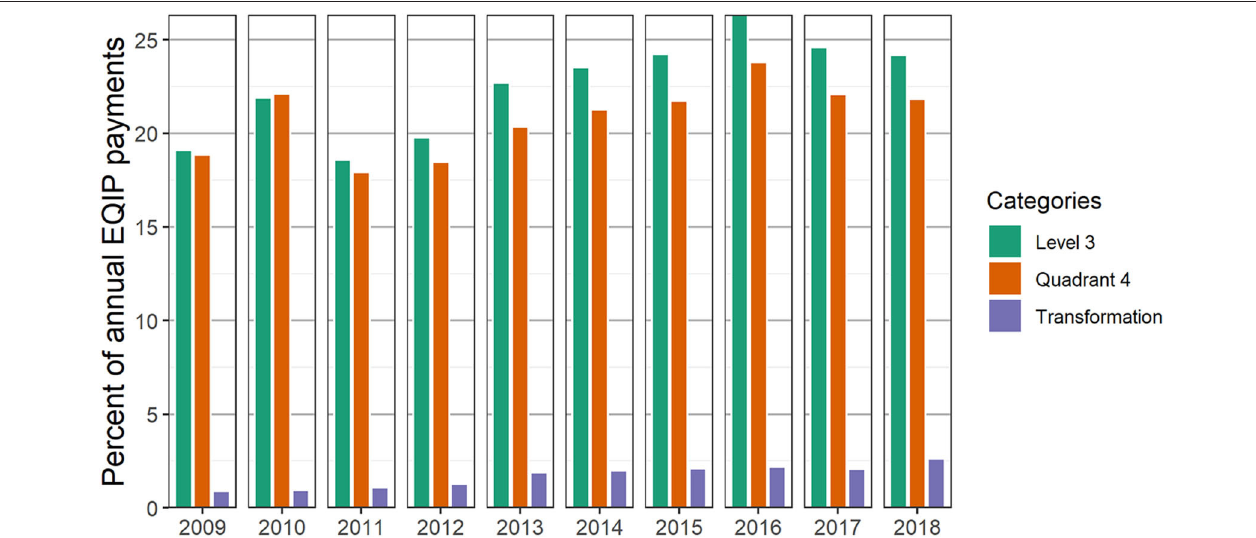
FIGURE 3 | Annual percent of total EQIP conservation practice investments from 2009 to 2018 dedicated to practices that were categorized as having the greatest potential to improve soil health (green), transition to ecologically-based management (orange), and expand adaptive strategy that were also executed in-situ on managed lands (purple). Total investments analyzed annually represented between $503 million (2018) up to $792 million (2013) ( Supplementary Table 2 ). Over this time period, Level 3 investments ranged from 19 to 26%, Quadrant 4 investments ranged from 18 to 24%, and Transformation investments ranged from 1 to 3% ( Supplementary Table 2